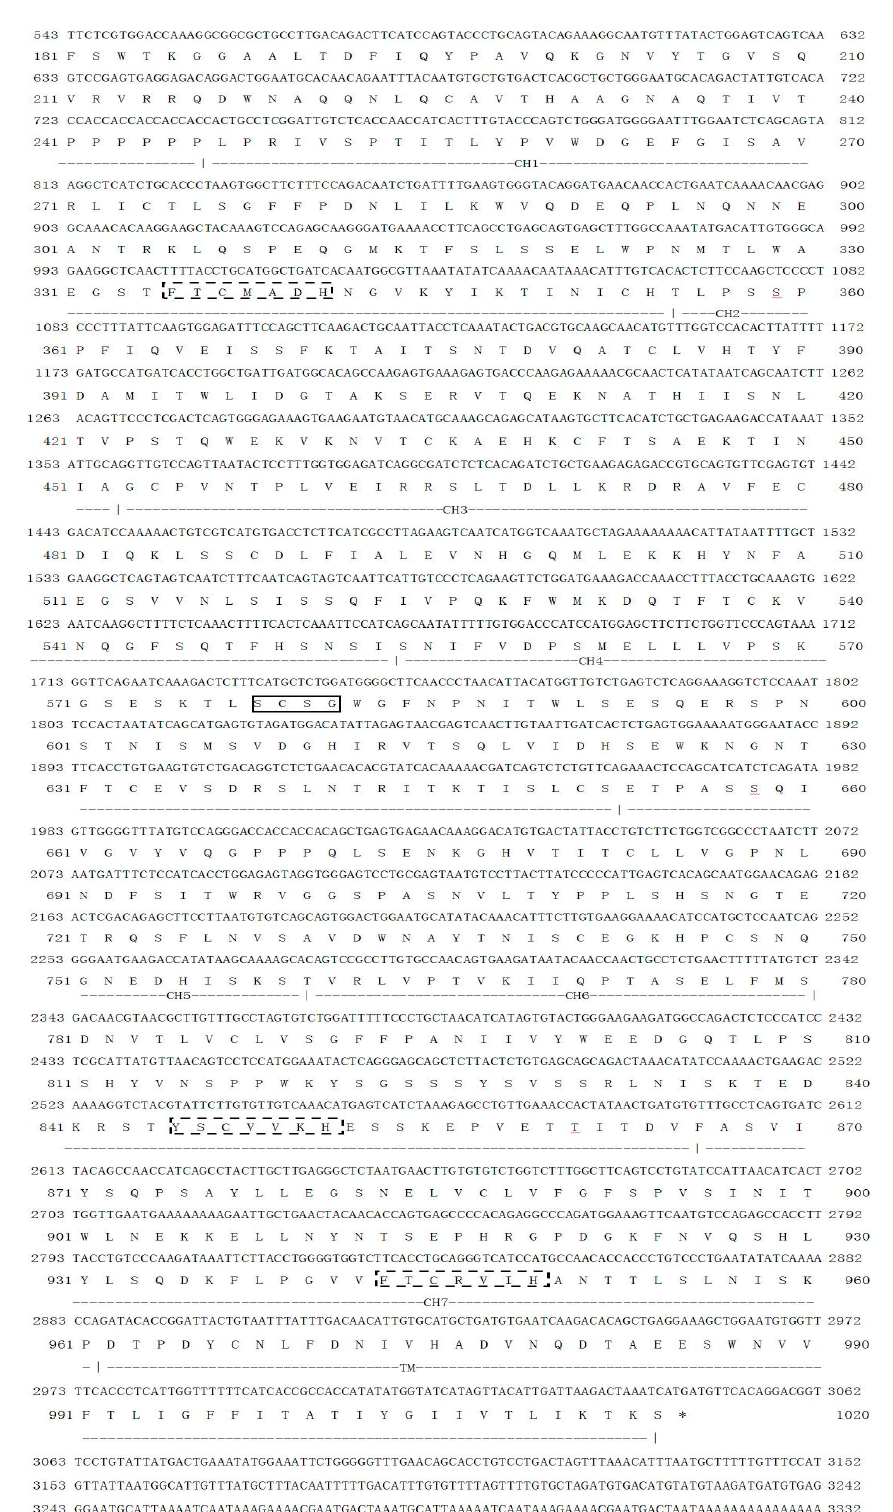
Figure 1. Cont. Figure 1. Nucleotide and amino acid sequence of Nile tilapia mIgD cDNA (GenBank Accession No. KF530821). Use the numbers on the left and right to show the nucleotide positions. The stop codon is represented with an asterisk (*). The polyadenylation signal is shown as underlined. The signal peptide domain, glycosaminoglycan attachment domain, and major histocompatibility complex proteins domain are shown as shaded, plain and dashed